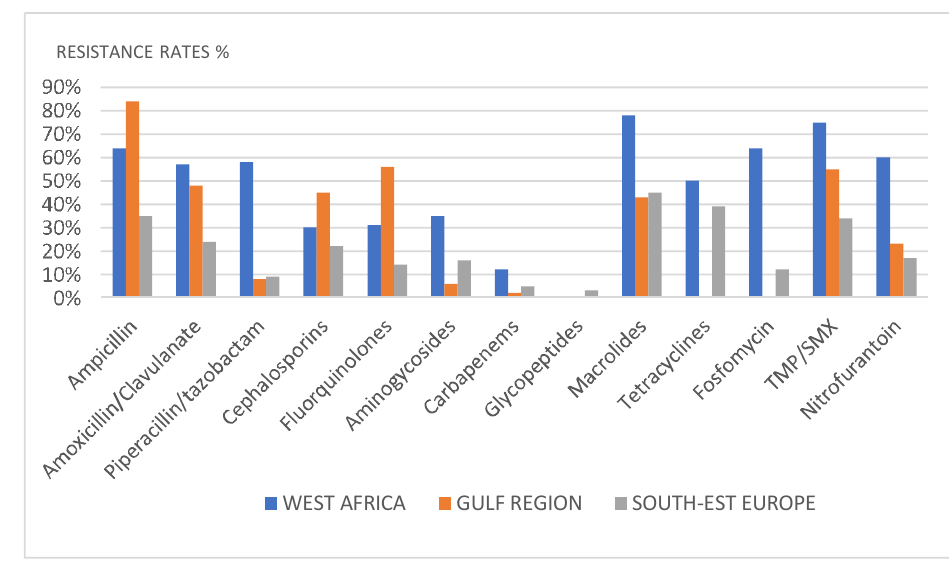
Figure 4. Resistance rates by geographical area.